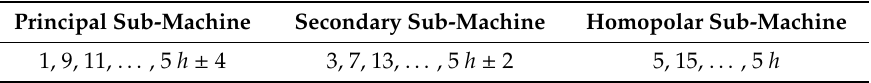
Table 1. Distribution rule of back-EMF harmonic components in a five-phase PMSG. Principal Sub-Machine Secondary Sub-Machine Homopolar